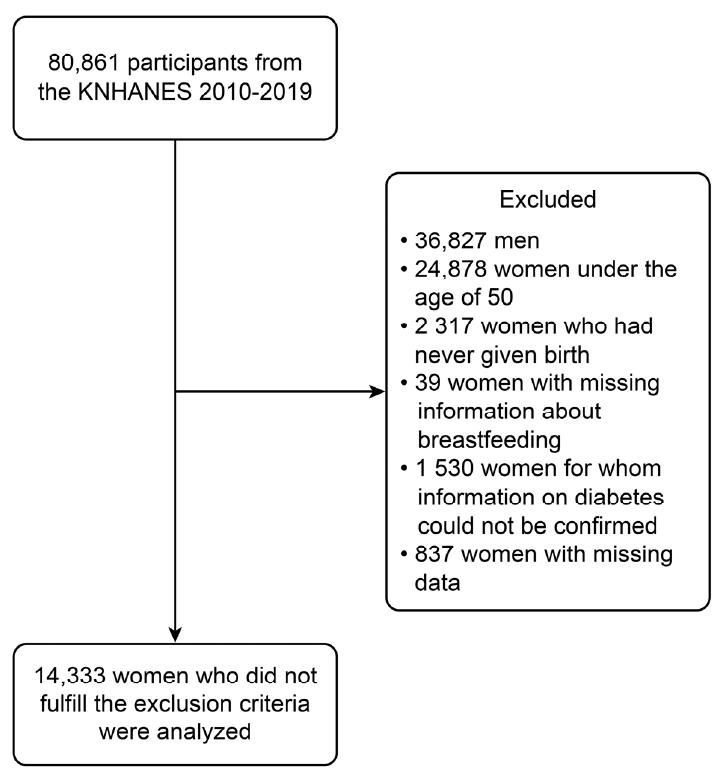
Figure 1. Participant flow diagram for final analysis.